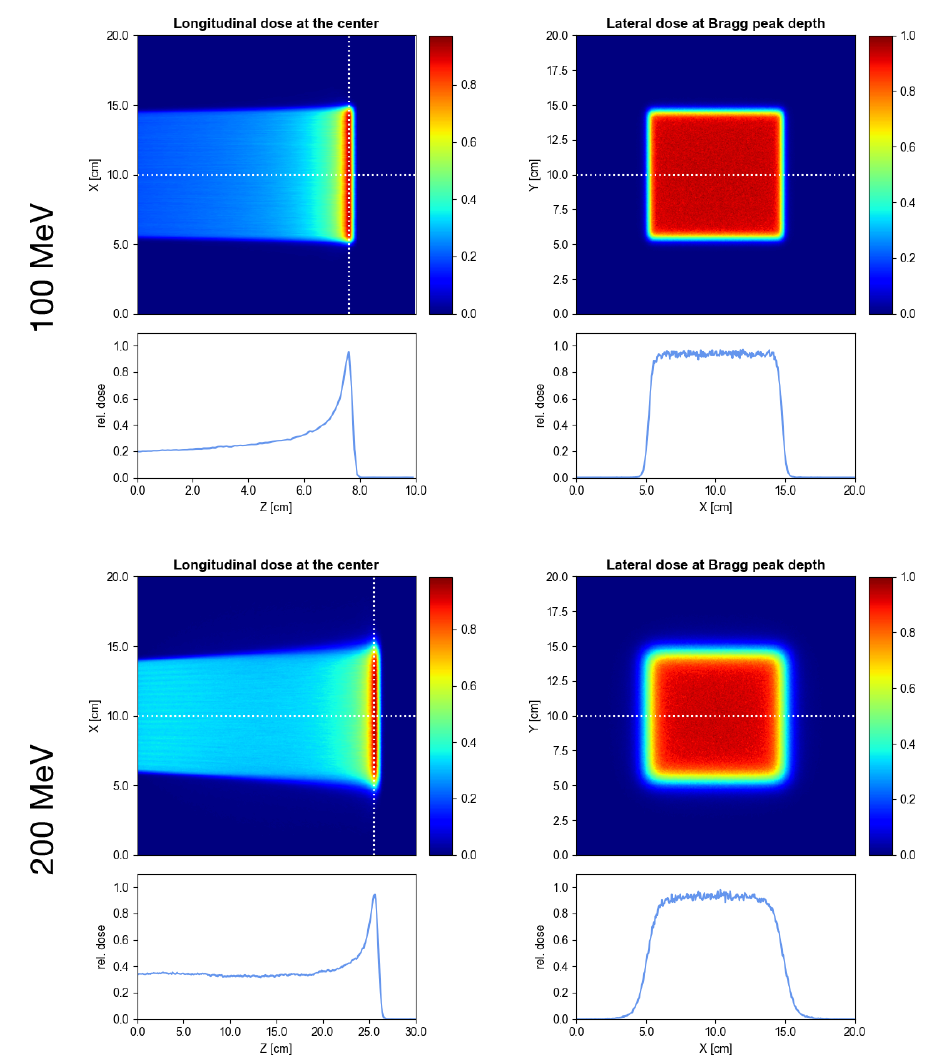
Figure 3. Lateral and longitudinal dose maps/profiles for an example pencil beam pattern at 100 MeV ( top ) and 200 MeV ( bottom ) assuming a 50 cm air gap. The vertical dotted line in the top left panel indicates the position in the Bragg peak where the lateral dose map was